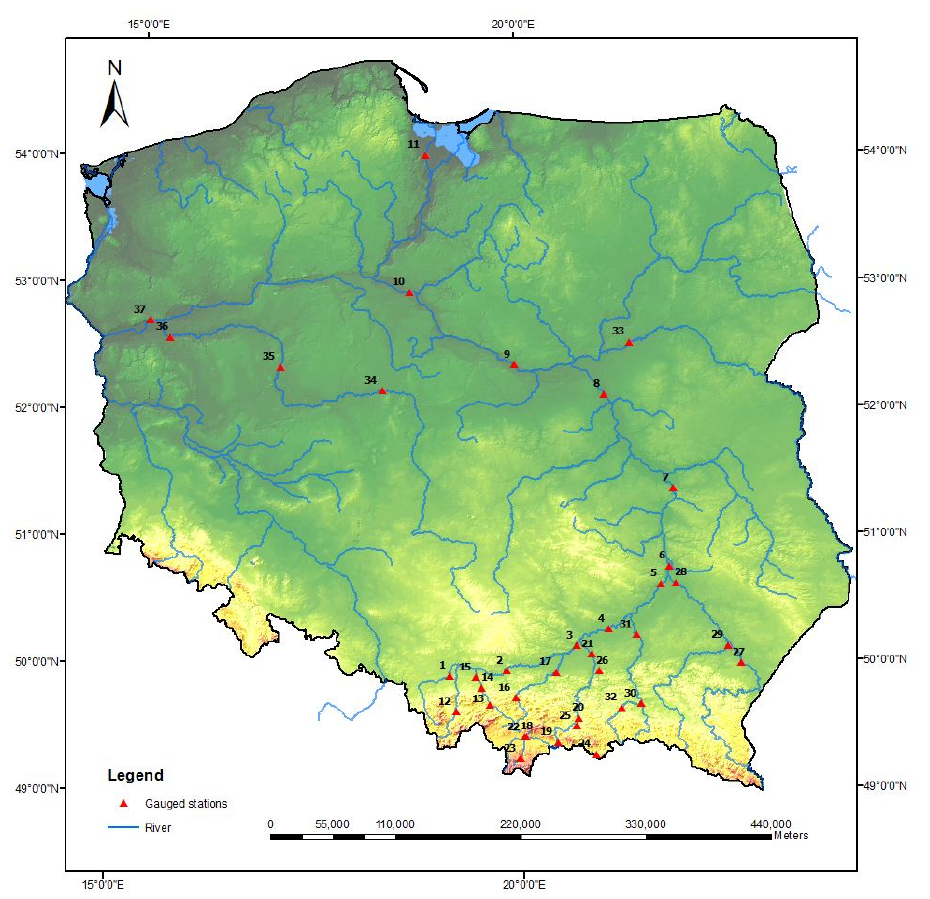
Figure 1. The location of 37 gauging stations at Polish rivers that were analyzed in this paper.